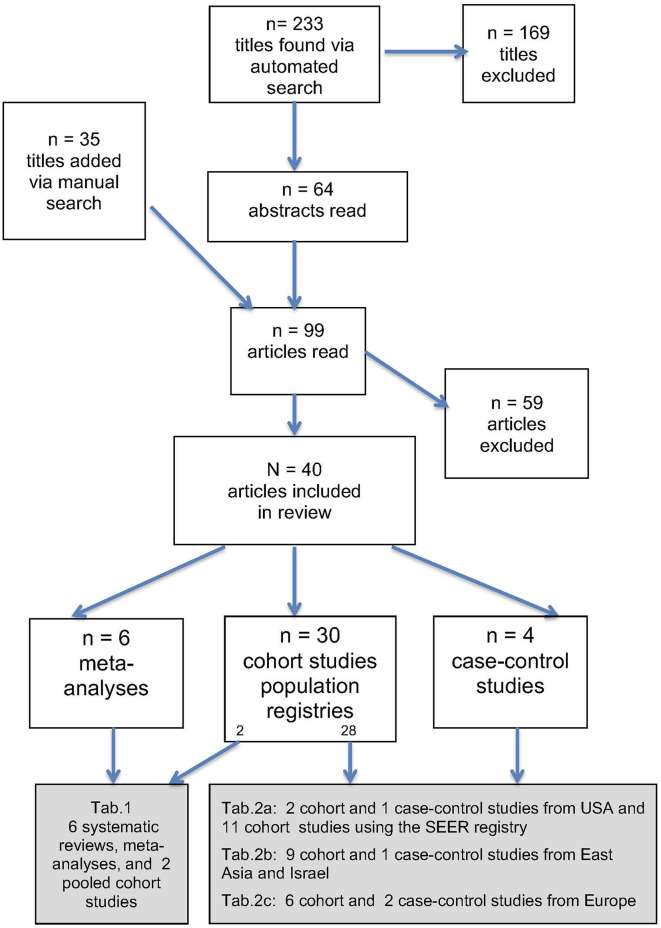
Flow diagram describing the literature search process.